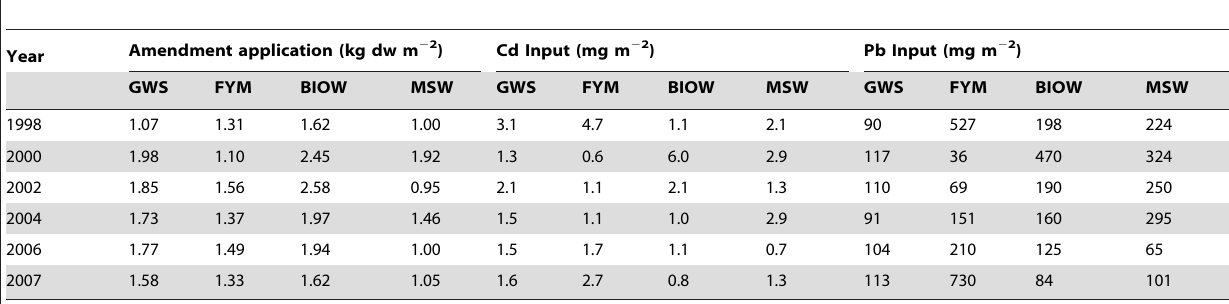
Table 2. Amendment application (second half of September in each given year) and input of Cd and Pb with amendment for the different